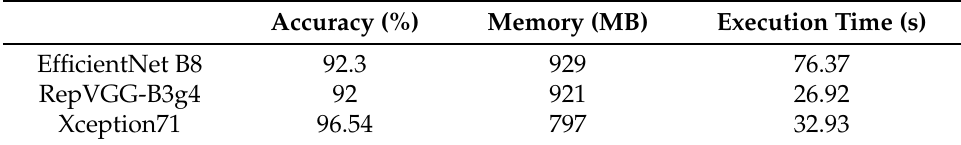
Table 1. Monitoring the implementation of the system for three CNN candidates.